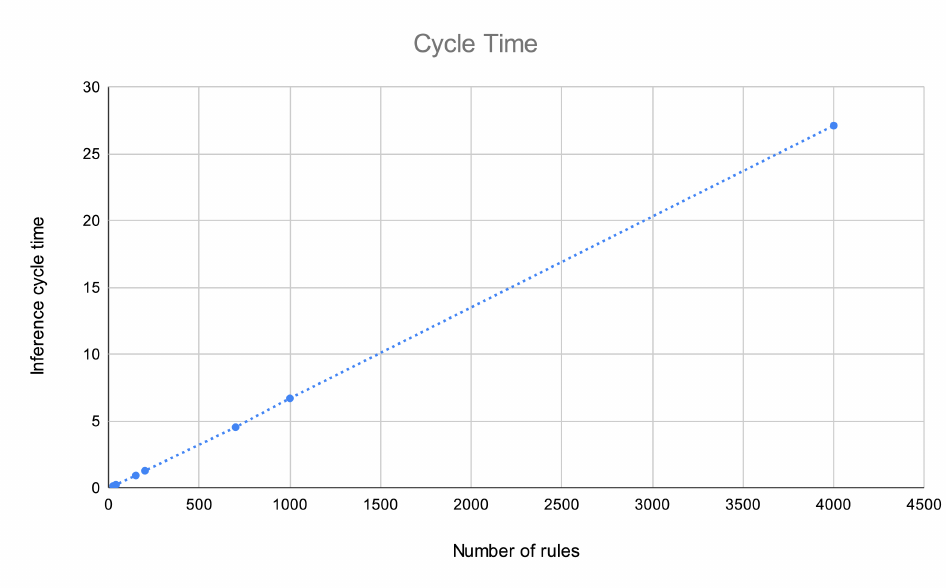
Figure 11. Correlation between inference cycle time and number of